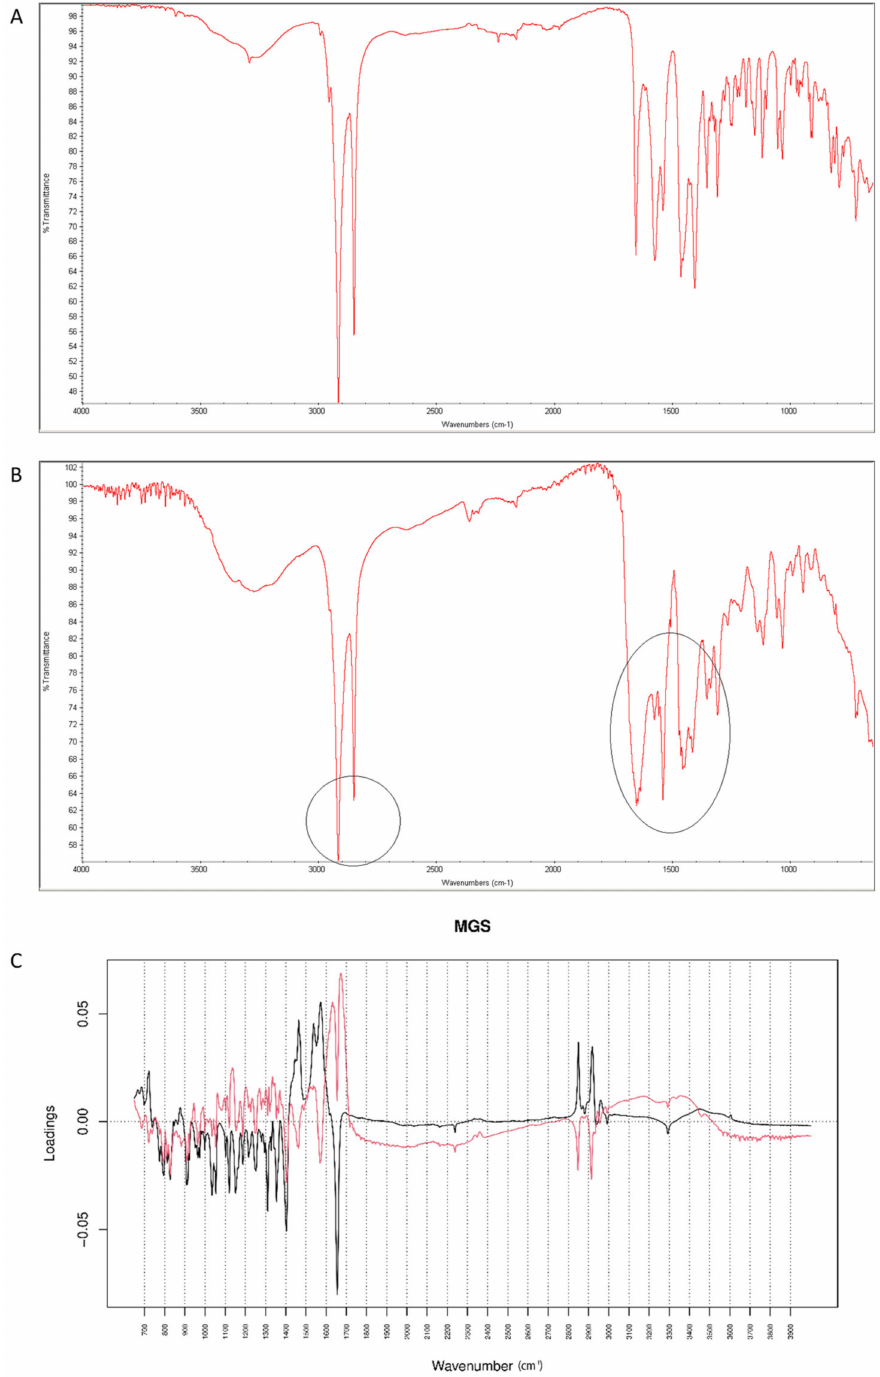
Figure 16. ( A – C ) Vildagliptin and magnesium stearate (MGS): mid-IR spectra of no stressed mixture ( A ), stressed mixture ( B ) and PCA loadings of the spectra ( C ); PC1 loadings are marked black while PC2 loadings are marked red, most visible differences in the spectrum of the stressed mixture are indicated with